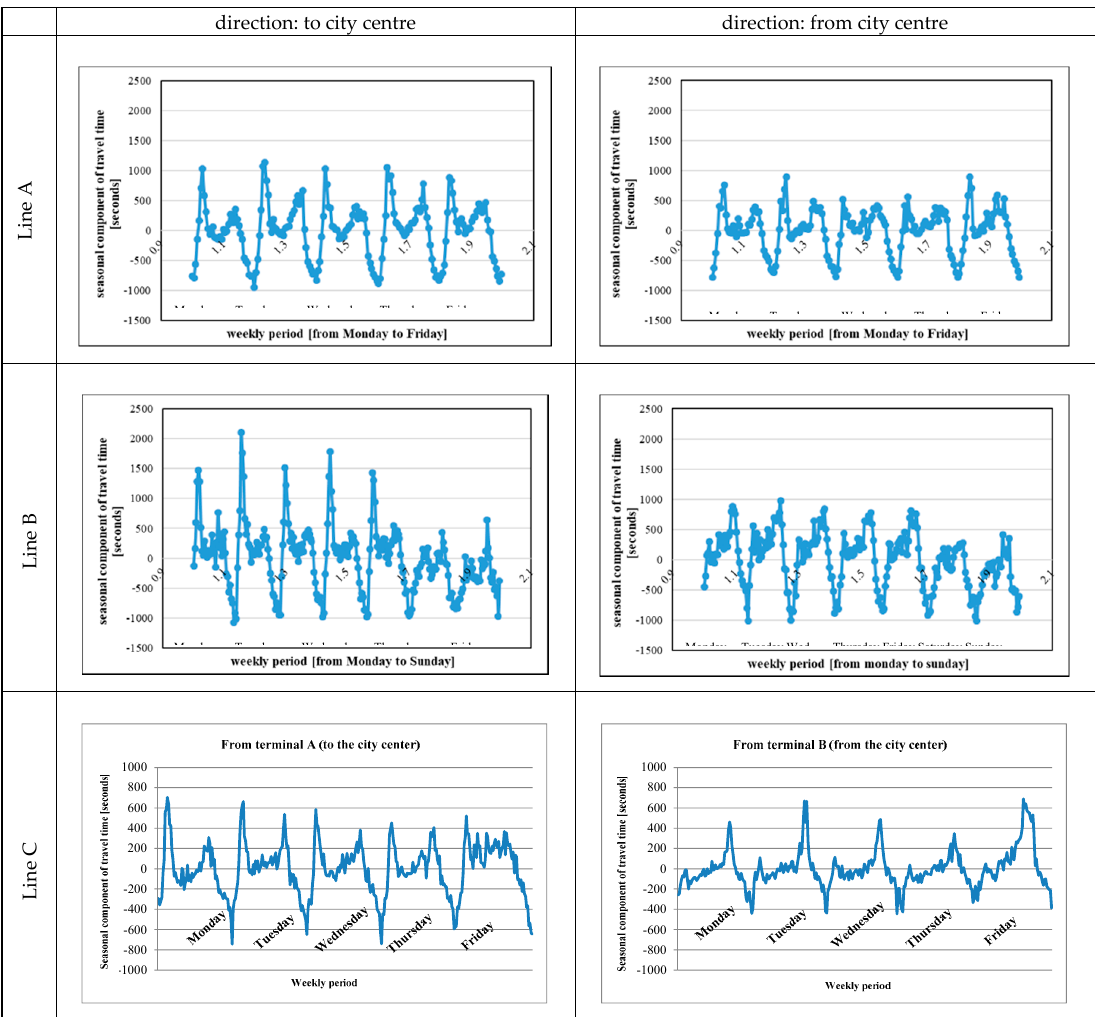
Figure 5. Travel time STL decomposition with weekly period (8 weeks): Lviv. direction: to city centre direction: from city centre